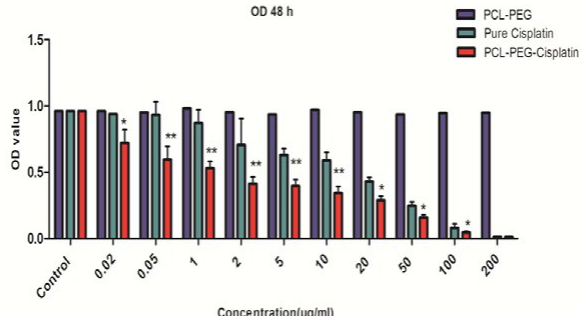
Fig. 5.b: The results of the treatment cells (A